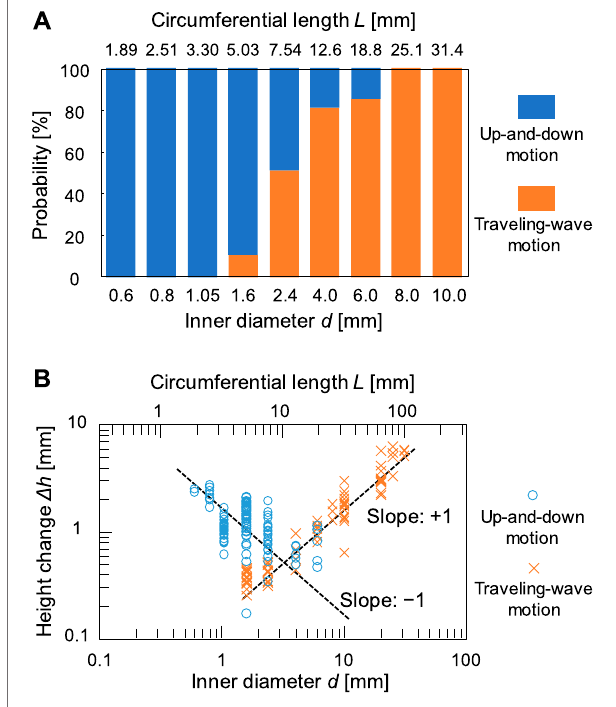
FIGURE 3 | (A) Relationship between probability of occurrence of the two modes and the inner diameter d of tubes and (B) double logarithmic plot of height change Δ h and d